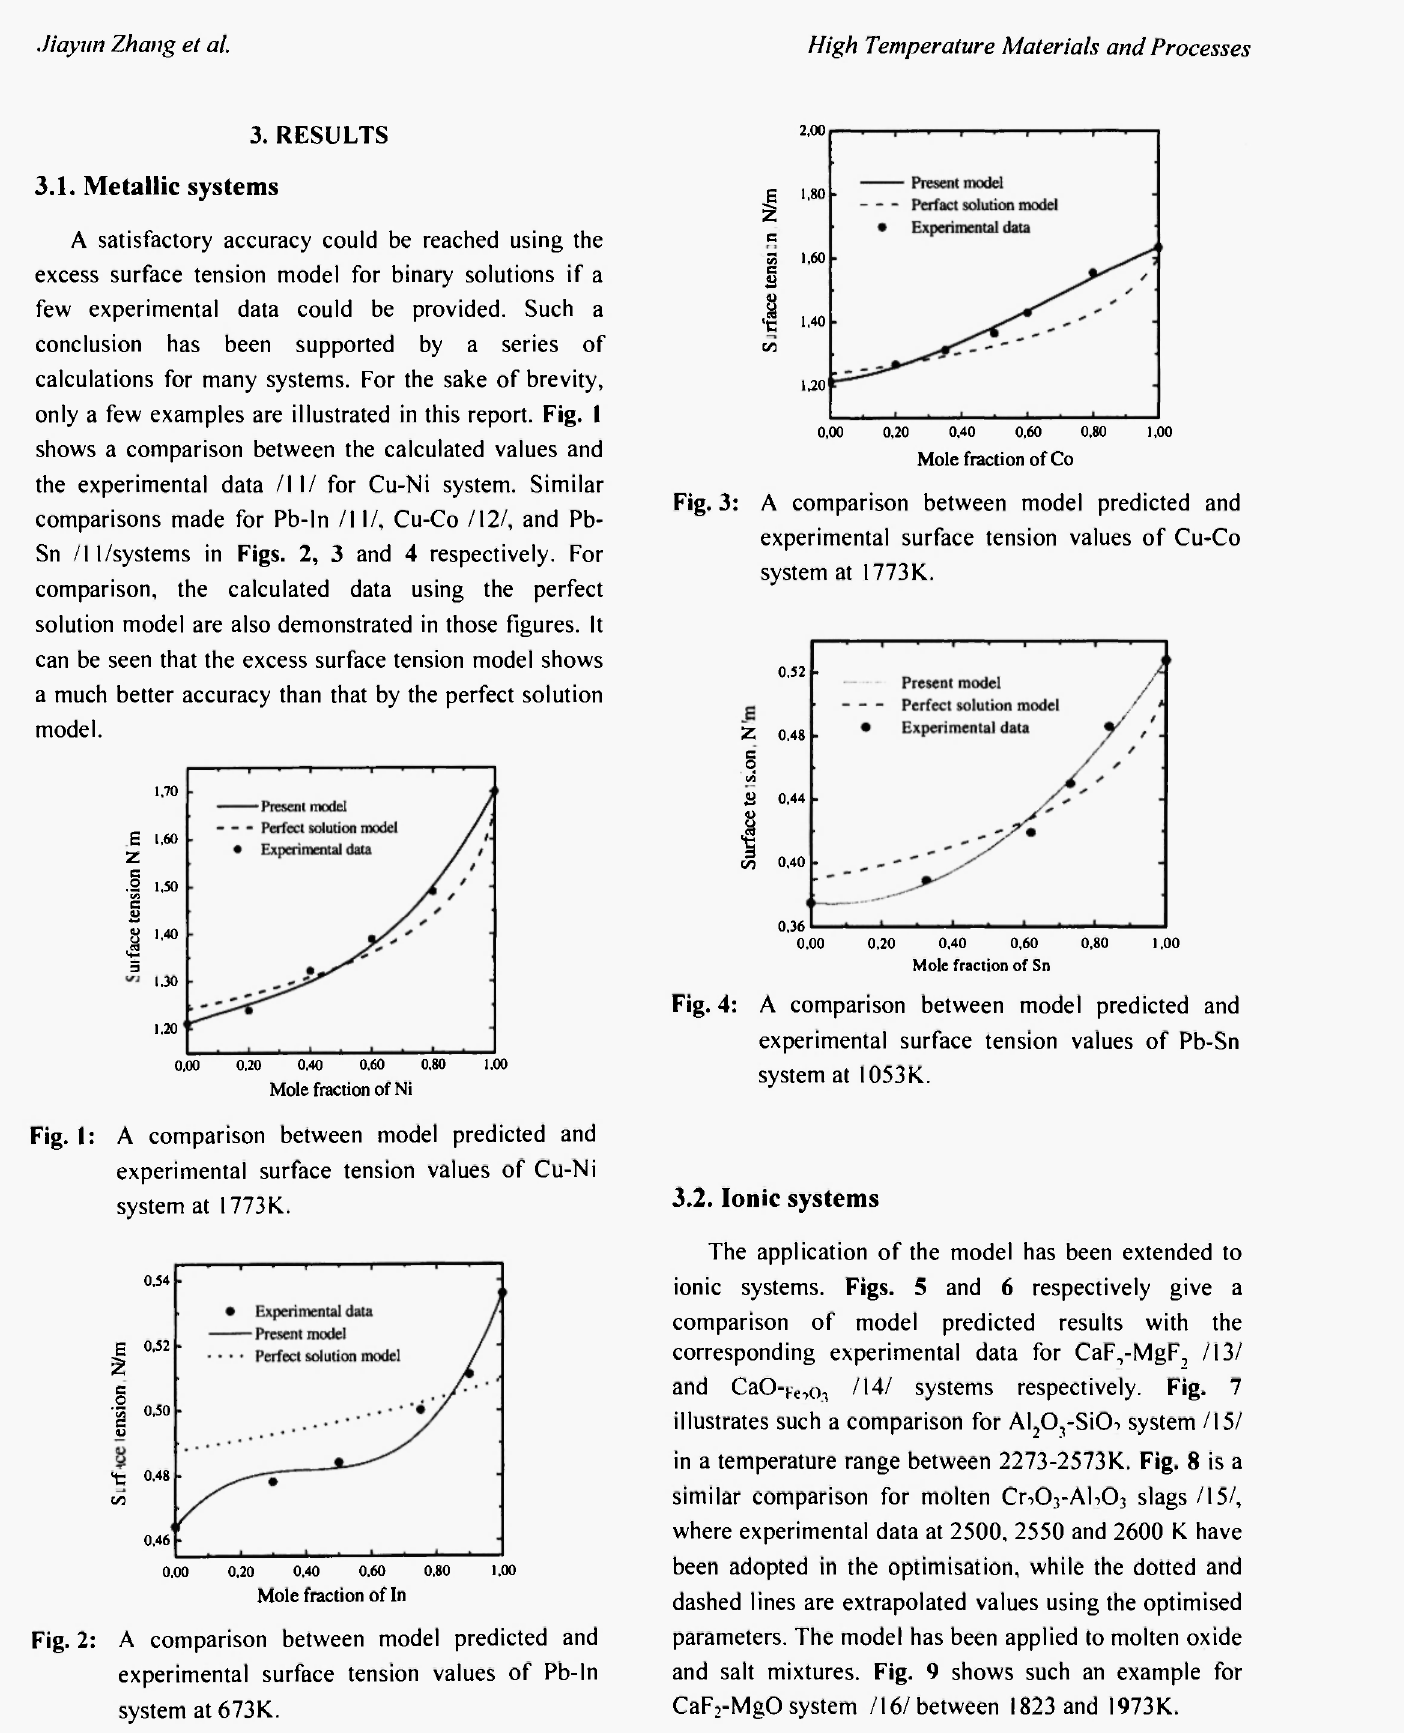
Fig. 2: A comparison between model predicted and experimental surface tension values of Pb-ln system at 673K.